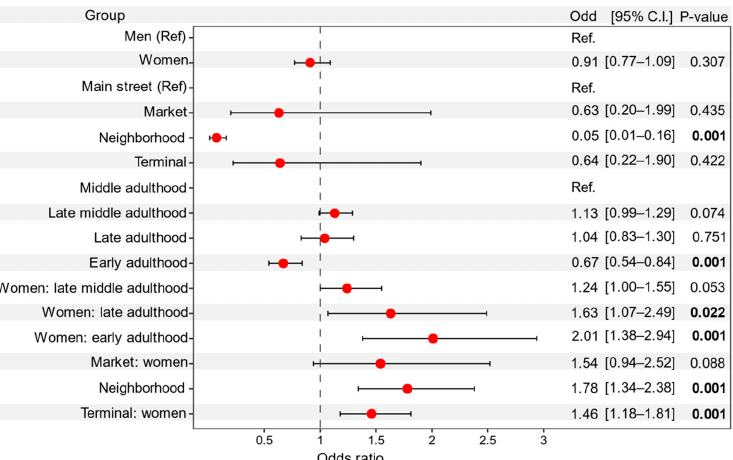
Figure 1. Odds ratios for people wearing a mask during the COVID-19 pandemic. Odds ratios and 95% confidence intervals for the group terms gender (men and women), place (mean street, market, neighborhood, and terminal), and age (early, middle, late-middle, and late adulthood). We included the interactions gender × place, and gender × age using a GLMM with a binomial distribution, accounting for the random effect of region, and place nested within the region. There were 36,441 observations included in the model. P-values denote the statistical significance of the model. Men, main streets, and middle adulthood were used as reference terms within their groups denoted as Ref.